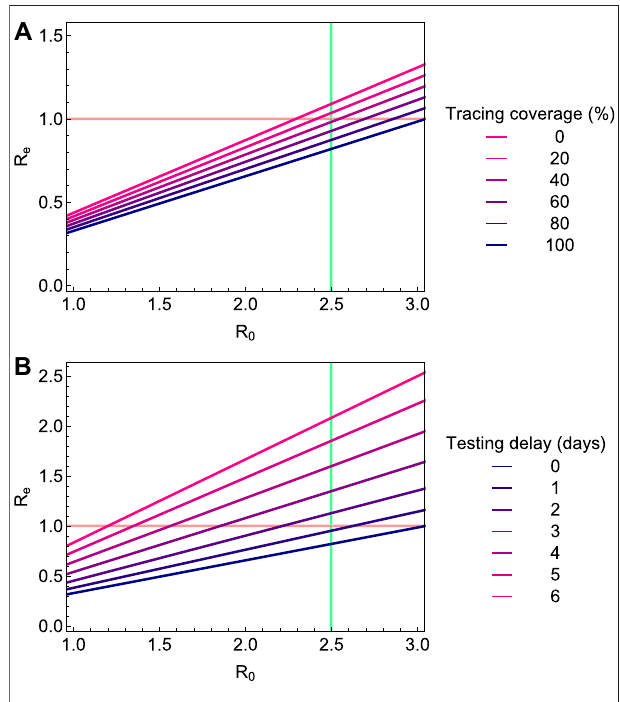
FIGURE 3 | The effective reproduction number R e for varying values of the basic reproduction number R 0 in the optimistic baseline scenario, and for various values of the tracing coverage for non-household contacts (A) or testing delay (B) .Tracingcoverage ofhouseholdcontactsisassumed to be